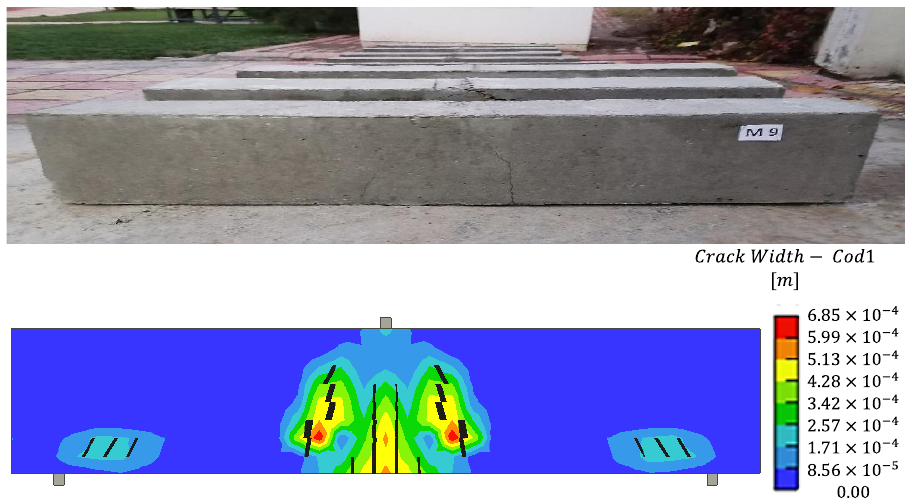
Figure 7. Model M9 verification.